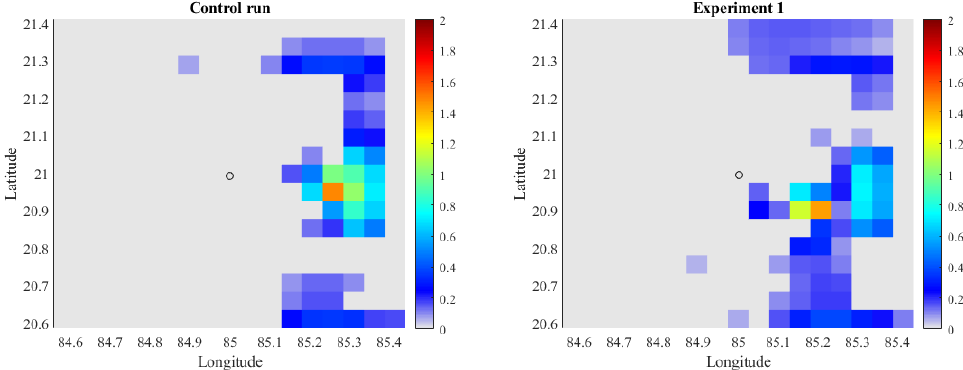
Figure 6. Median diameter comparisons on 16 August 2008 for WDM6 at near-surface level.